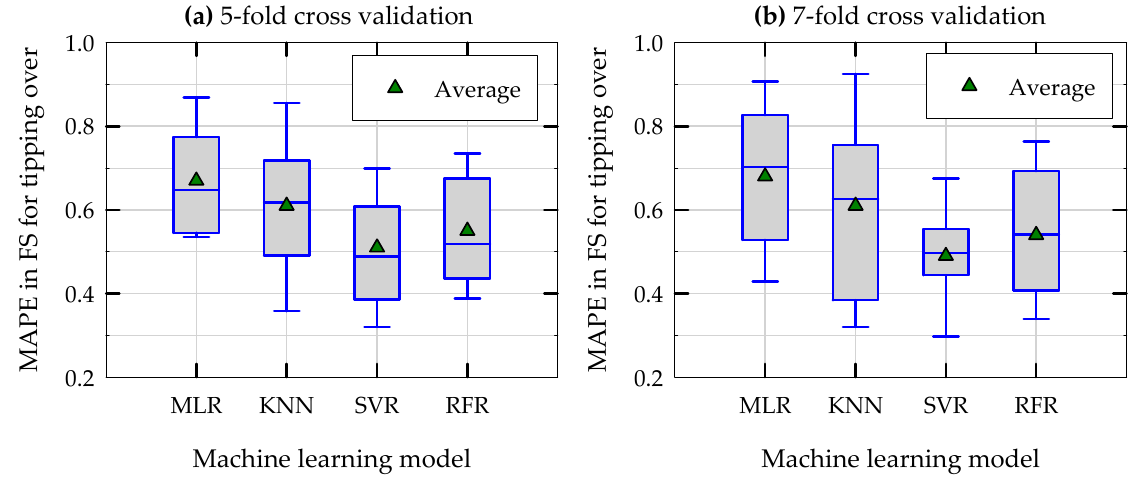
Figure 13. Boxplots of mean absolute percentage errors (MAPE) in the predictions of factor of safety for tipping-over of machine leaning models (k-fold testing error): ( a ) repeated 5-fold cross validation and ( b ) repeated 7-fold cross validation.